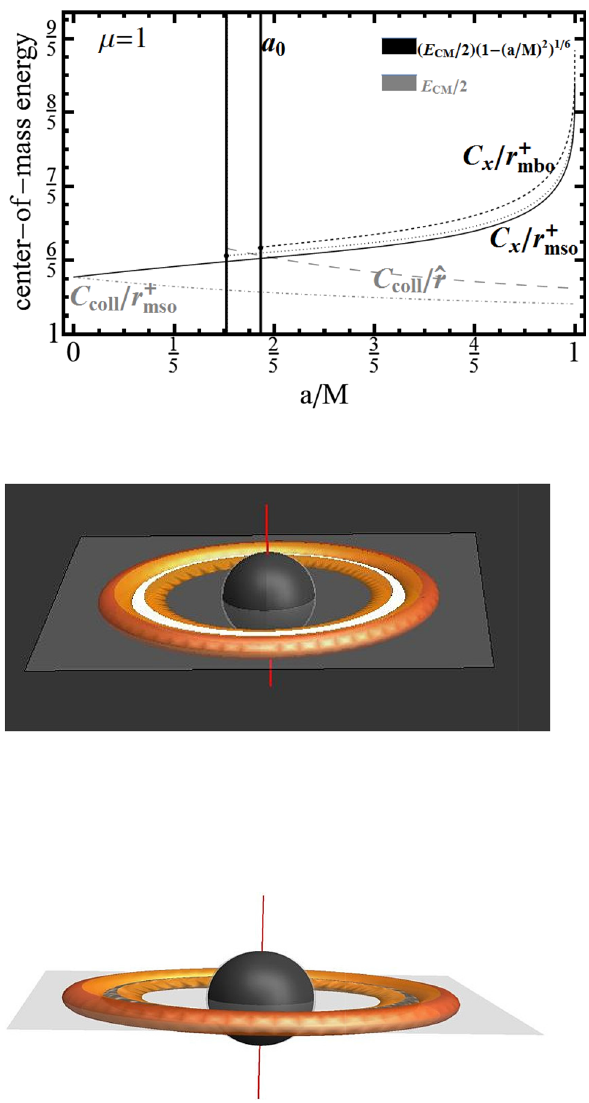
Fig. 14 Upper panel: center-of-mass energy E CM / 2 in the test particle approximation, versus a / M , for the couples () − << × C + × – Figs. 1 and -dashed- 2. We consider: infalling particle from r + mso black curve ( r + mbo black curve) of C × colliding configuration. They are labeled respec- tively as C × / r + mso (black curve) and C × / r + (dashed-black curve)). mbo Dotted black curve is for a particle from orbit ˆ r ≡ r + mso − 2 M colliding on a circular orbiting particle located at r − mso -(for the asymptote-factor ( 1 − ( a / M ) 2 ) 1 / 6 ). Collision of counterrotating particles on an inner corotating thin ring at r + mso ( ˆ r ) are indicated with C coll / r + mso (dotted- dashed gray curve) and C coll / ˆ r (dashed gray curve) respectively, – see also [90]. Main notation is also listed in Table 1. Center panel: GRHD - numerical 3D integration of Eq. (7) proving the density surfaces of < C − colliding (cid:4) corotating C − o couple of corotating ( C coll ) tori, with i = 3 . 3 and (cid:4) − = 3 . 4 and K parameter specific angular momentum (cid:4) − o i ( K − = 0 . 927 , K − = 0 . 935 ) respectively. Black region is r < r + , r + o i is the outer horizon of the black hole of spin a = 0 . 385 M , gray region is the outer ergosurface, color are chosen according to improved visual effect, integration is stopped at the emerging of tori collision – see also Fig. 1. Bottom panel , different view of the colliding couple C coll to enlighten the colliding region. Tori are coplanar and centered on the central BH orbiting on its equatorial